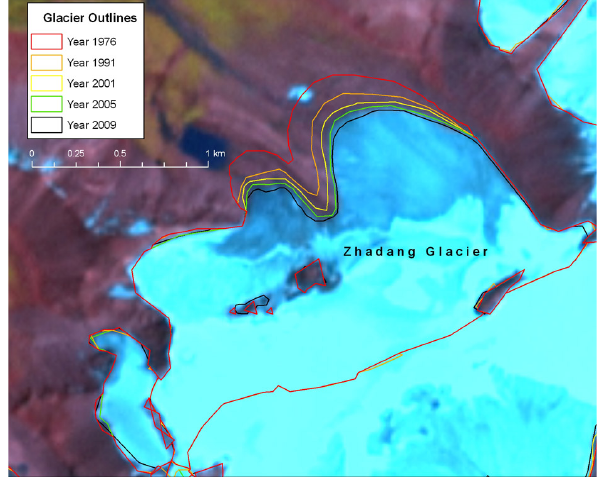
Fig. 6. Area changes of Zhadang Glacier